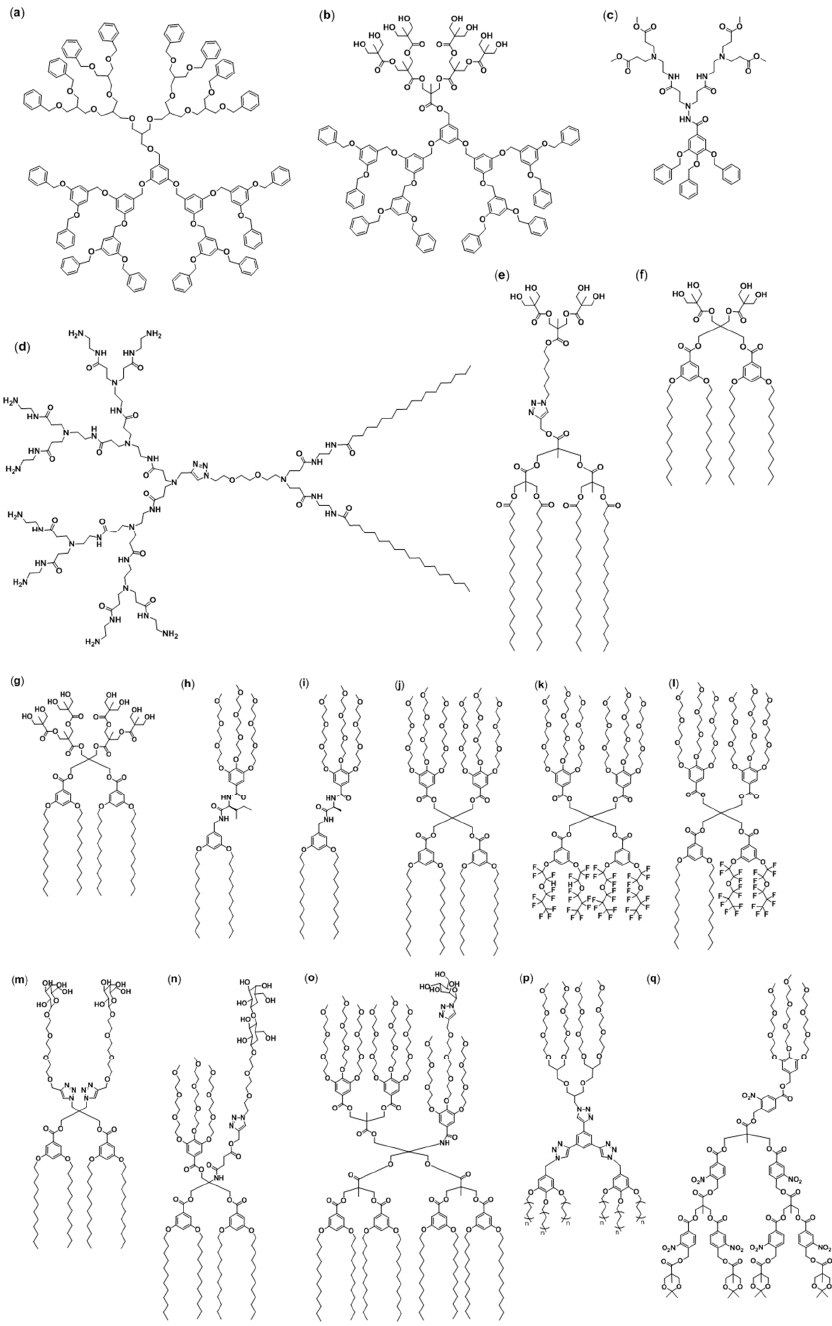
Figure 3. Structures of Janus dendrimers that form dendrimersomes: in organic solvents ( a , b , p );